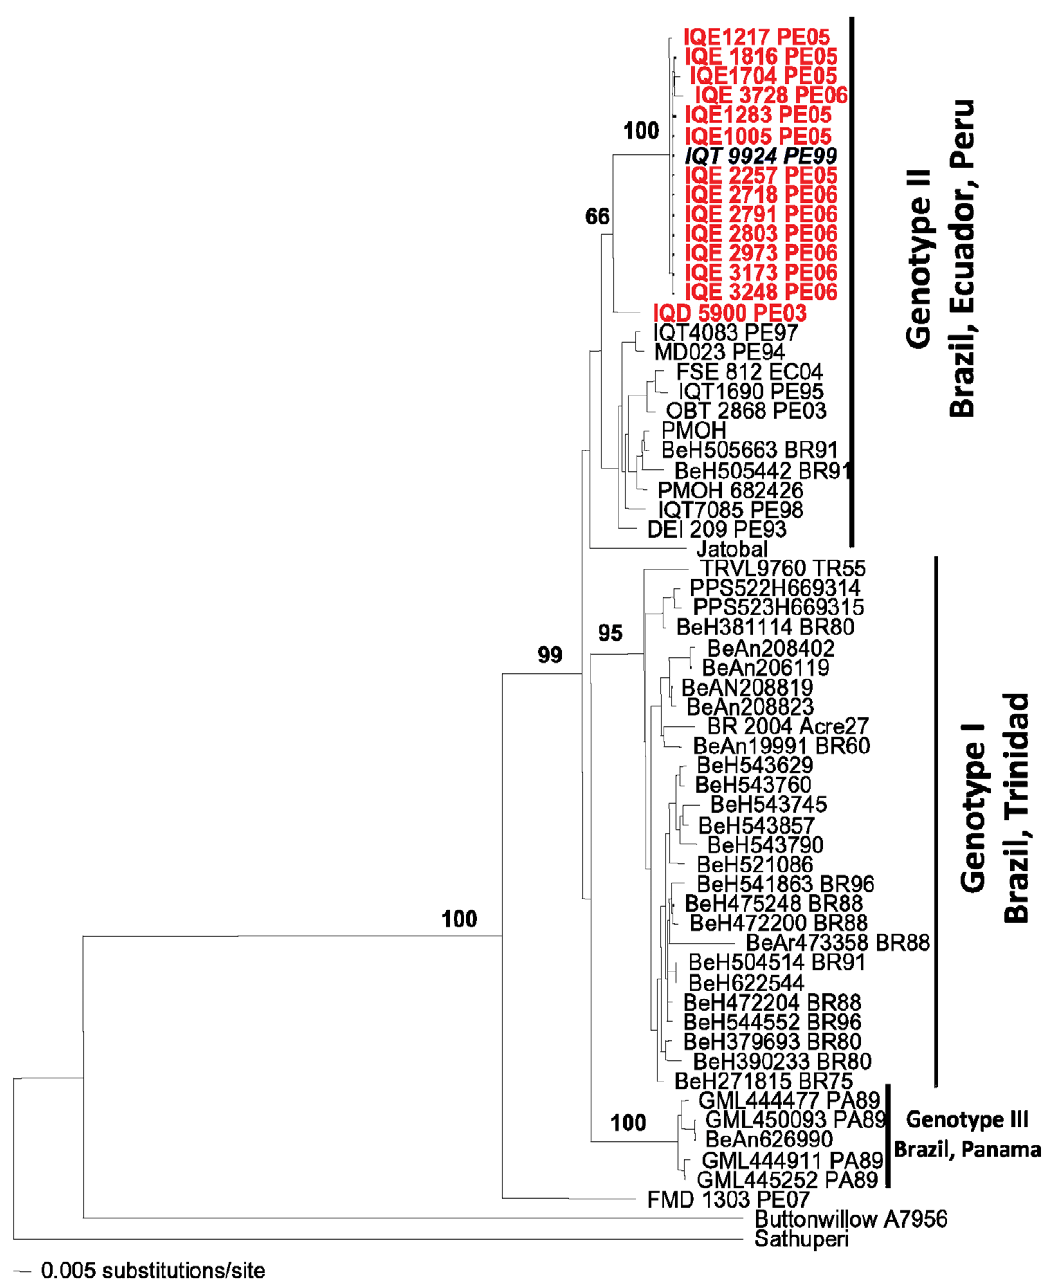
Figure 1. Neighbor joining phylogenetic tree of the Oropouche virus based on the S segment. The tree was derived from recently generated partial nucleoprotein gene sequences of recent ORO-like virus isolates from Peru (depicted in red or italics) and previously published homologous sequences, using the neighbor joining program. Virus strains are labeled by code designation. The tree was rooted using an outgroup comprised of Sathuperi virus. Numbers indicate bootstrap values for the clades to the right.